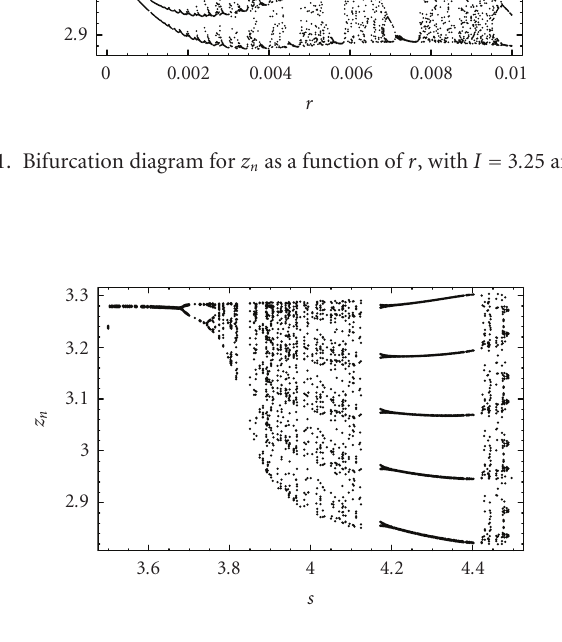
Figure 2.22. Bifurcation diagram for z n as a function of s , with I = 3 . 25 and r = 0 .